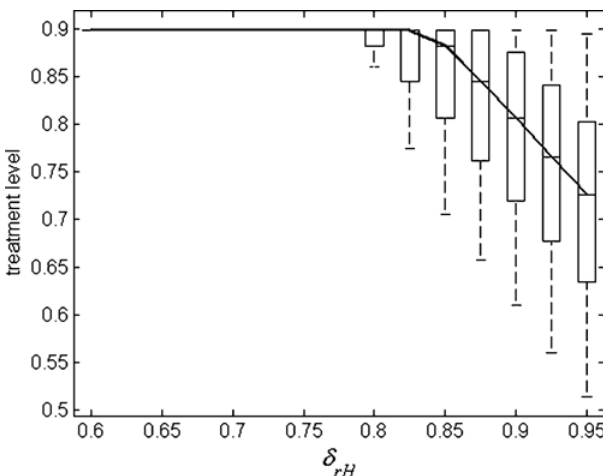
Figure 4. Sensitivity analysis showing box plots for the variations in the optimal constant treatment level (below 90%) as a function of d rH , with other parameters sampled from their respective ranges, as described in ‘‘Text S1’’. The solid curve passes through the median values of the treatment level, and each box contains 50% of data points between the first and third quartiles of the sampling distribution. The remaining 50% of data points are represented by whiskers.